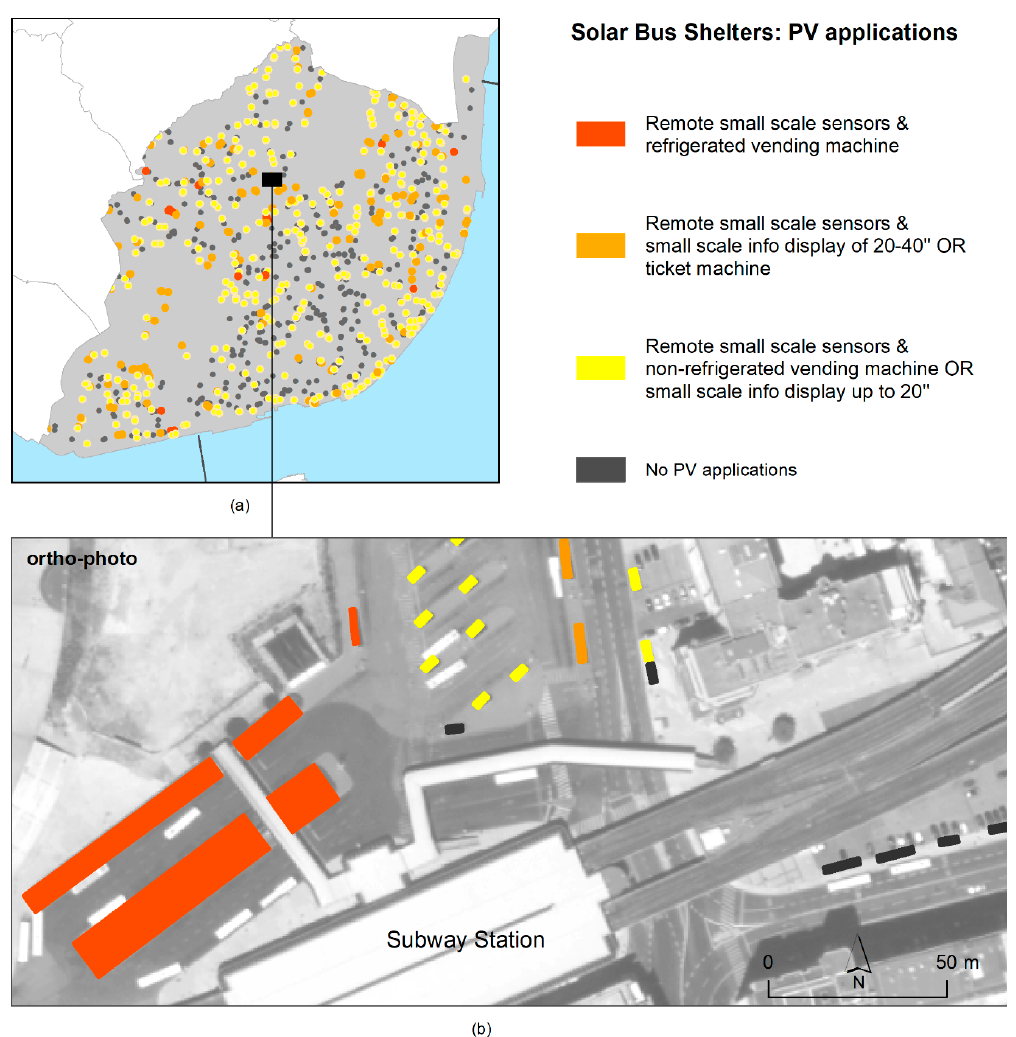
Figure 9. Solar bus shelters with typified PV applications ( a ), and an interface station example ( b ).